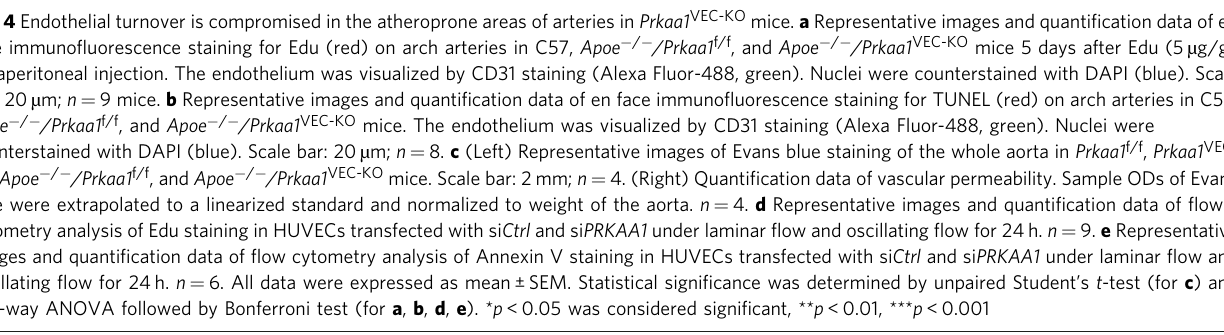
Fig. 4 Endothelial turnover is compromised in the atheroprone areas of arteries in Prkaa1 VEC-KO mice. a Representative images and quanti fi cation data of en face immuno fl uorescence staining for Edu (red) on arch arteries in C57, Apoe − / − /Prkaa1 f/f , and Apoe − / − /Prkaa1 VEC-KO mice 5 days after Edu (5 µ g/g) intraperitoneal injection. The endothelium was visualized by CD31 staining (Alexa Fluor-488, green). Nuclei were counterstained with DAPI (blue). Scale bar: 20 µ m; n = 9 mice. b Representative images and quanti fi cation data of en face immuno fl uorescence staining for TUNEL (red) on arch arteries in C57, Apoe − / − /Prkaa1 f/f , and Apoe − / − /Prkaa1 VEC-KO mice. The endothelium was visualized by CD31 staining (Alexa Fluor-488, green). Nuclei were counterstained with DAPI (blue). Scale bar: 20 µ m; n = 8. c (Left) Representative images of Evans blue staining of the whole aorta in Prkaa1 f/f , Prkaa1 VEC- KO , Apoe − / − /Prkaa1 f/f , and Apoe − / − /Prkaa1 VEC-KO mice. Scale bar: 2 mm; n = 4. (Right) Quanti fi cation data of vascular permeability. Sample ODs of Evans blue were extrapolated to a linearized standard and normalized to weight of the aorta. n = 4. d Representative images and quanti fi cation data of fl ow cytometry analysis of Edu staining in HUVECs transfected with si Ctrl and si PRKAA1 under laminar fl ow and oscillating fl ow for 24 h. n = 9. e Representative images and quanti fi cation data of fl ow cytometry analysis of Annexin V staining in HUVECs transfected with si Ctrl and si PRKAA1 under laminar fl ow and oscillating fl ow for 24 h. n = 6. All data were expressed as mean ± SEM. Statistical signi fi cance was determined by unpaired Student ’ s t -test (for c ) and one-way ANOVA followed by Bonferroni test (for a , b , d , e ). * p < 0.05 was considered signi fi cant, ** p < 0.01, *** p <